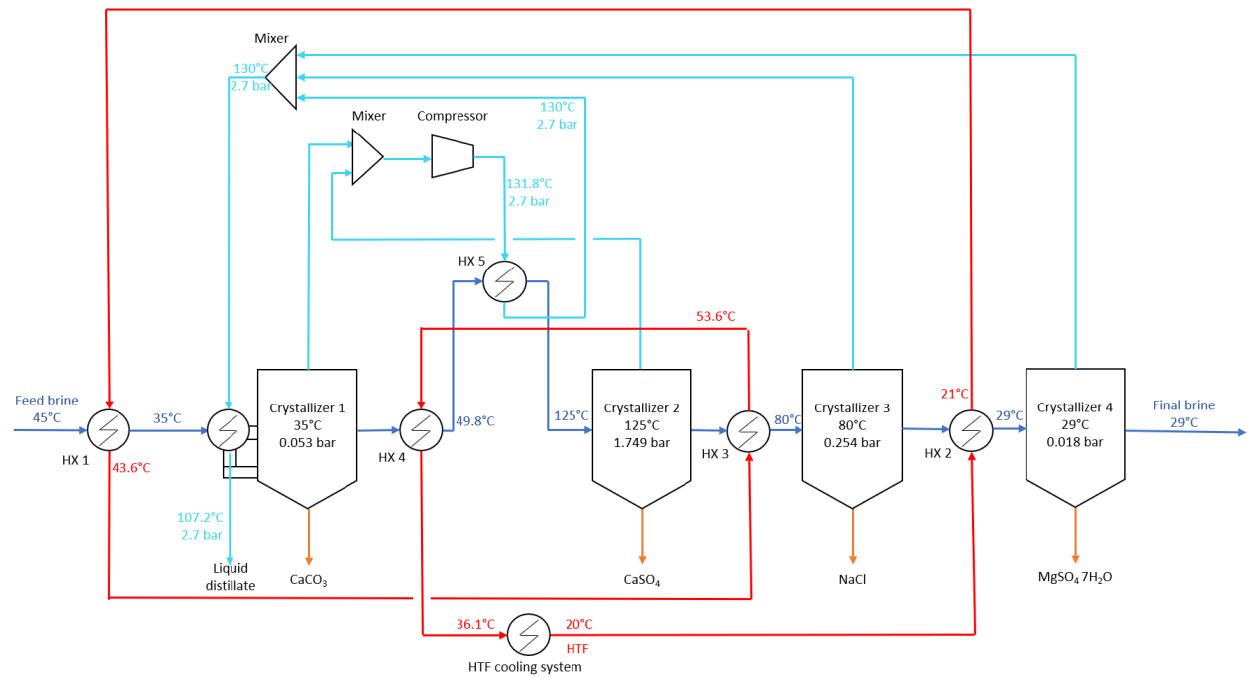
Figure 5 . Schematic of the multi-crystallization with the addition of a HTF for heat recovery. Figure 5. Schematic of the multi-crystallization with the addition of a HTF for heat